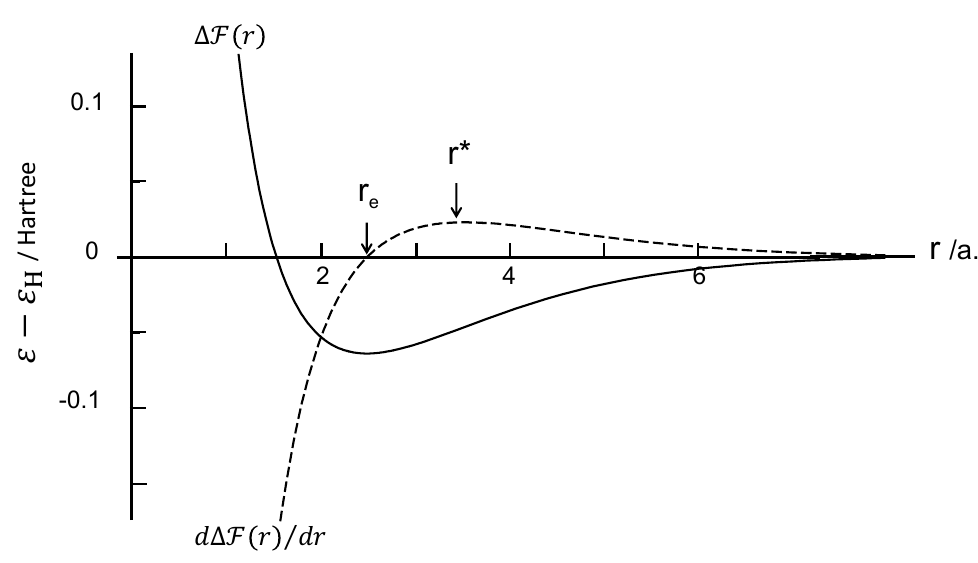
Figure 5. Free energy and attractive force in Hartree unit plotted against the interproton distance in atomic unit